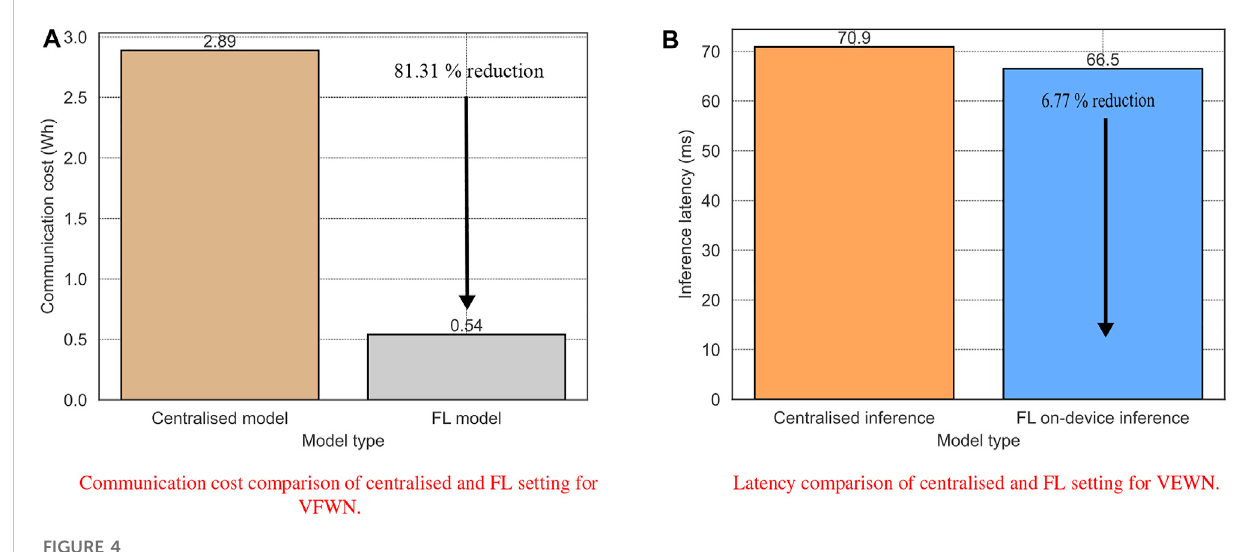
FIGURE 4 Comparisionofcommunicationcost (A) andlatencyanalysis (B) forVFWN.Theproposedschemeresultsin81.31%reductionincommunicationcost and 6.77% reduction in inference latency.